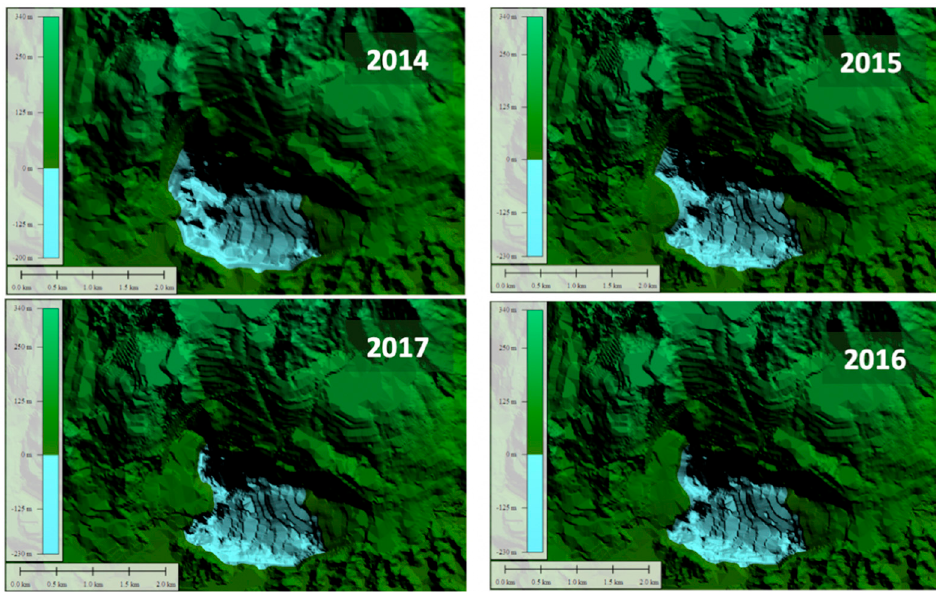
Figure 7. Backflling. Figure 7.